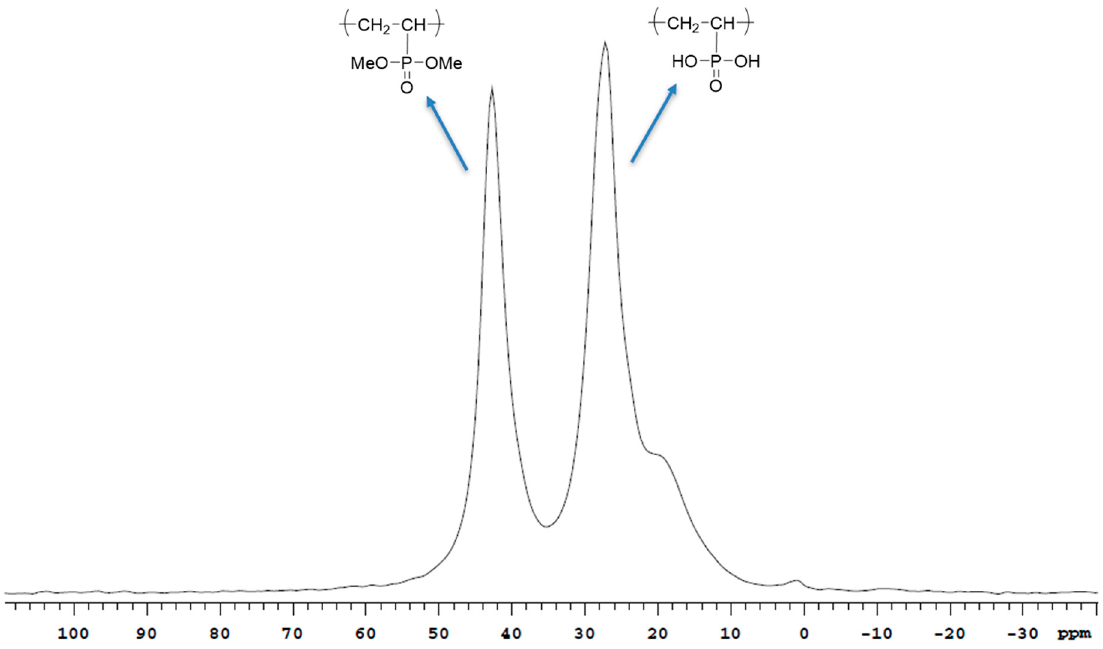
Figure 9. Solid state 31 P NMR spectrum of hydrolyzed crosslinked poly(VDF- ter -VPA- ter -VTEOS) terpolymer ( HCP 20 ).